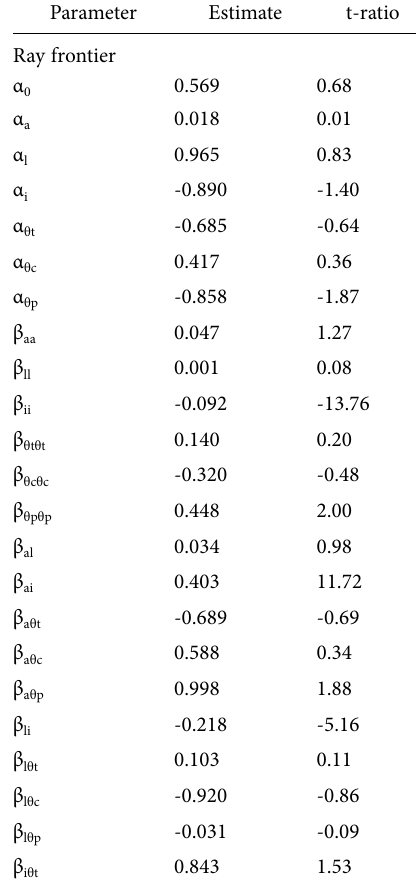
Table 4. Estimated stochastic ray production